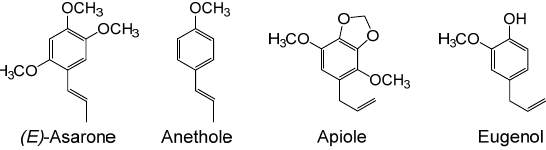
Figure 2. Chemical structures of several phenylpropanoid volatile compounds.